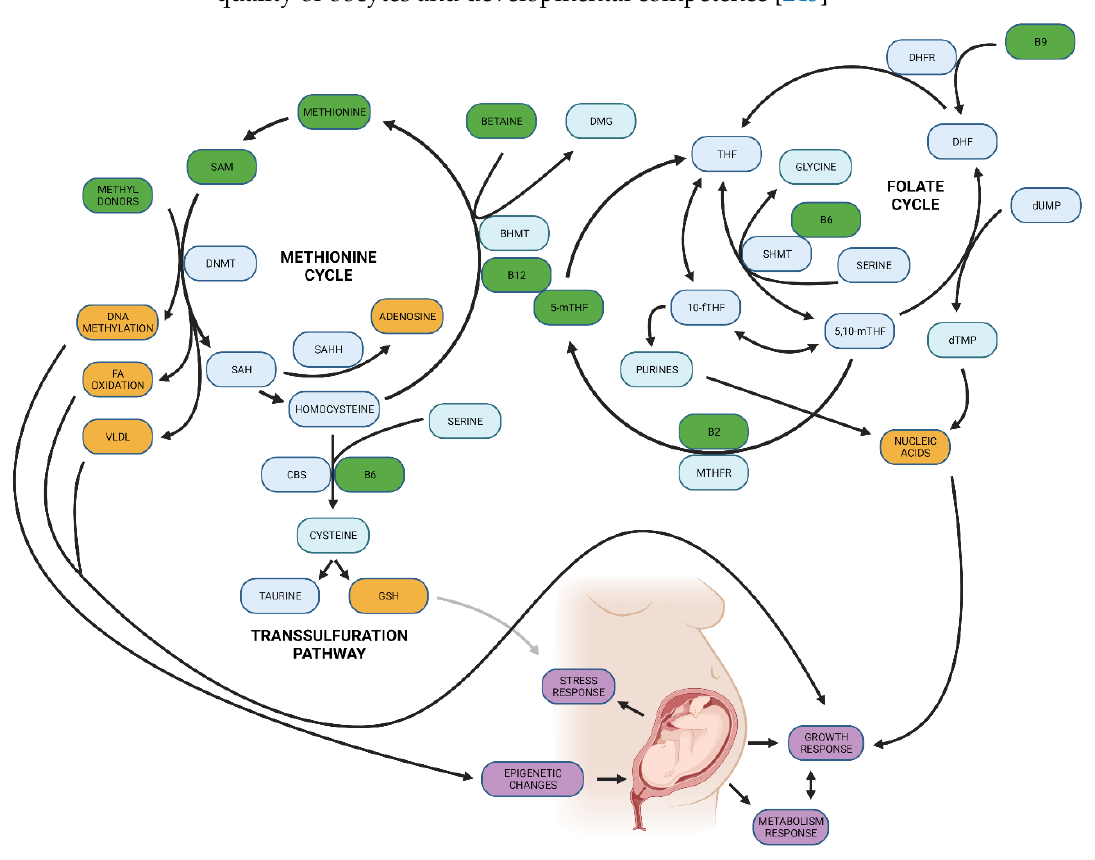
Figure 5. One-carbon metabolism (OCM)-associated pathways in nutrition and epigenetics: Many OCM compounds are nutritional supplements (green) such as B vitamins; Riboflavin (B2), Pyridoxine (B6), Folate (B9), or Cobalamin (B12). 5-methyl-tetrahydrofolate (5-mTHF) or methionine and betaine are another currently introduced nutritional supplements. OCM path- ways produce molecules for epigenetic modifications [239], antioxidant production [240], and building compounds of nucleic acids, amino acids, or phospholipids (orange) [241], which are all together influencing in utero fetal development (purple). Abbreviations: 5,10-mTHF, 5,10-methenyl-tetrahydrofolate; 10-fTHF, 10-formyl-tetrahydrofolate; BHMT, betaine-homocysteine S-methyltransferase; CBS, cystathionine β -synthase; DHF, dihydrofolate; DHFR, dihydrofolate reductase; DMG, dimethylglycine; DNMTs, de novo and maintenance DNA methyltransferases; dTMP, deoxythymidine monophosphate; dUMP, deoxyuridine monophosphate; FA, fatty acids; GSH, reduced glutathione; MTHFR, 5,10-methylenetetrahydrofolate reductase; SAH, S-adenosylhomocysteine; SAHH, S-adenosylhomocysteine hydrolase; SAM, S-adenosylmethionine; SHMT, serine hydroxymethyltransferase; THF, tetrahydrofolate; VLDL, very-low density lipoprotein. The image was created with Bio- Render.com.